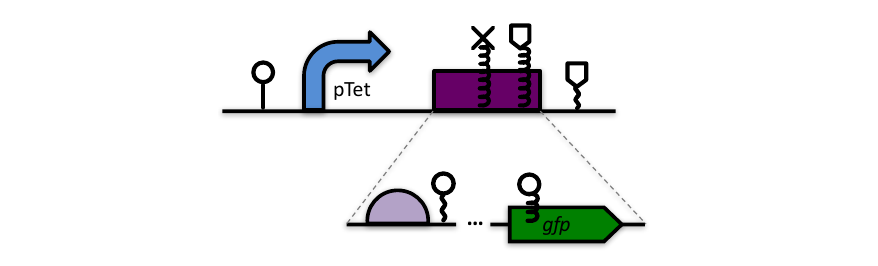
Figure 33: Detailed design of a promoter, in which the transcription start site is preceded by two operator sites where regulators bind.